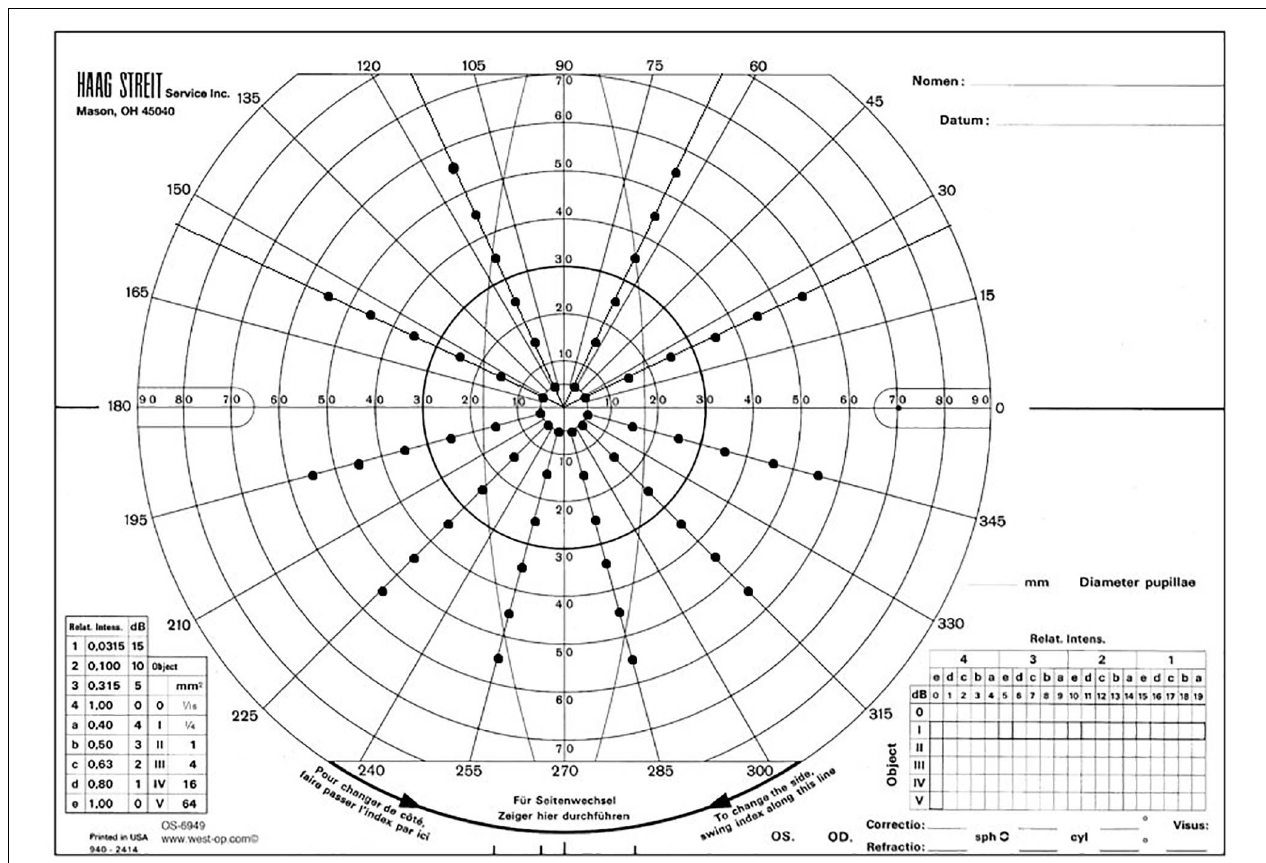
FIGURE 1 | Modified AMA scoring grid on a Goldmann VF scoring sheet for functionally scoring VF. This figure was adapted from the unpublished report of Mann and Ravensbergen. Protocol for AMA-Style Analysis of Visual Field, 2019 (Mann and Ravensbergen,